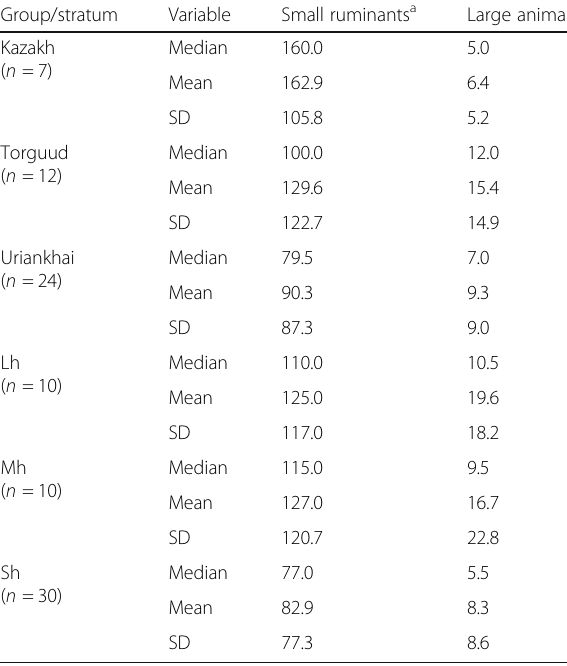
Households owning large herds (Lhs), medium-size herds (Mhs) and small herds (Shs)